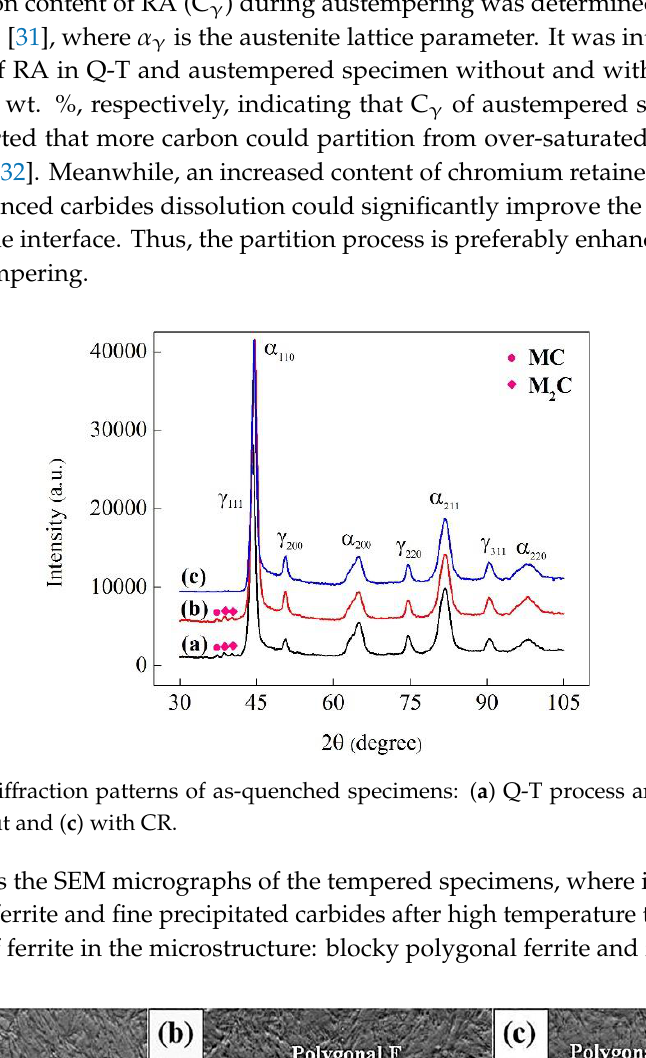
Figure 7. X-ray diffraction patterns of tempered specimens: ( a ) Q-T process and austempering process ( b ) without and ( c ) with CR. The TEM micrographs of the Q-T and austempered specimen with CR are shown in Figure 8. Figure 8a depicts the microstructure of Q-T specimen after quenching, which mainly consists of M and blocky RA. The duplex microstructure of austempered specimen with CR is demonstrated in Figure 8b, illustrating that many sub-plates interact with each other, whereas thin-film of RA is sandwiched between the sub-plates. It is also hard to distinguish bainite and martensite in the M/B duplex microstructure. After tempering, blocky polygonal ferrite and a small amount of precipitates are obtained in Figure 8c. However, a finer microstructure comprised of fine equiaxed ferrite can be obtained in Figure 8d, which illustrates that more fine precipitates disperse within the ferrite-ferrite interfaces.